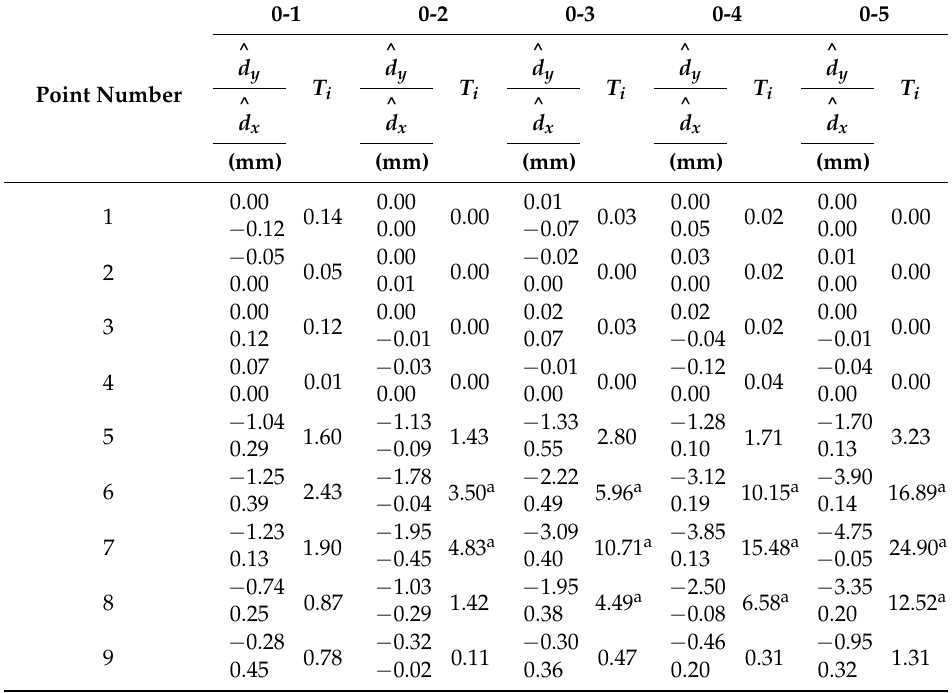
Table 3. Geodetic measurement